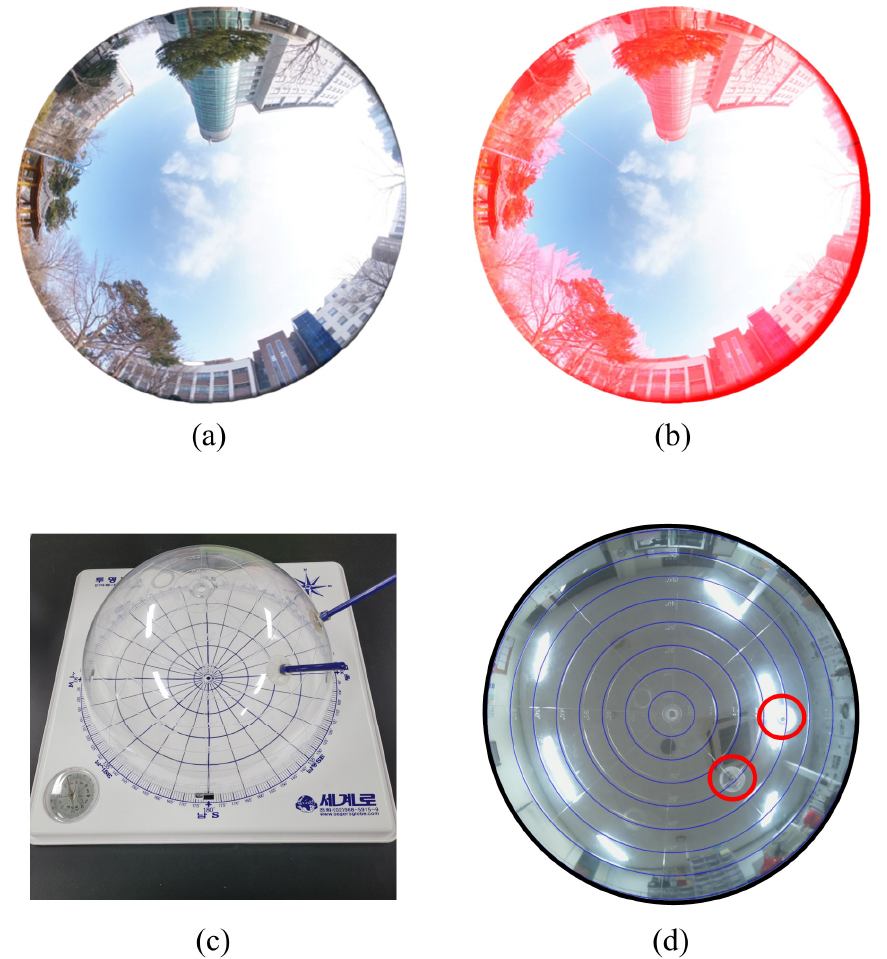
Figure 8. Conversion of panoramic image to ( a ) polar image, ( b ) result of sky classification, ( c ) trans- parent hemisphere, and ( d ) image taken within it (the red circles are the positions where the bars are a tt ached).